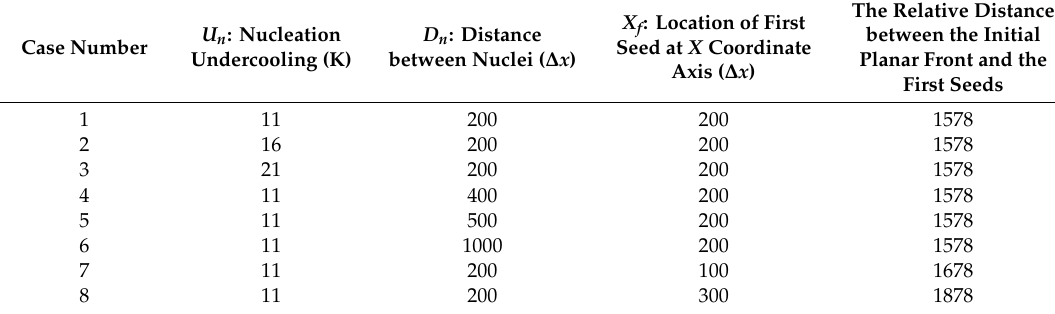
Table 2. The growth condition of heterogeneous nuclei.